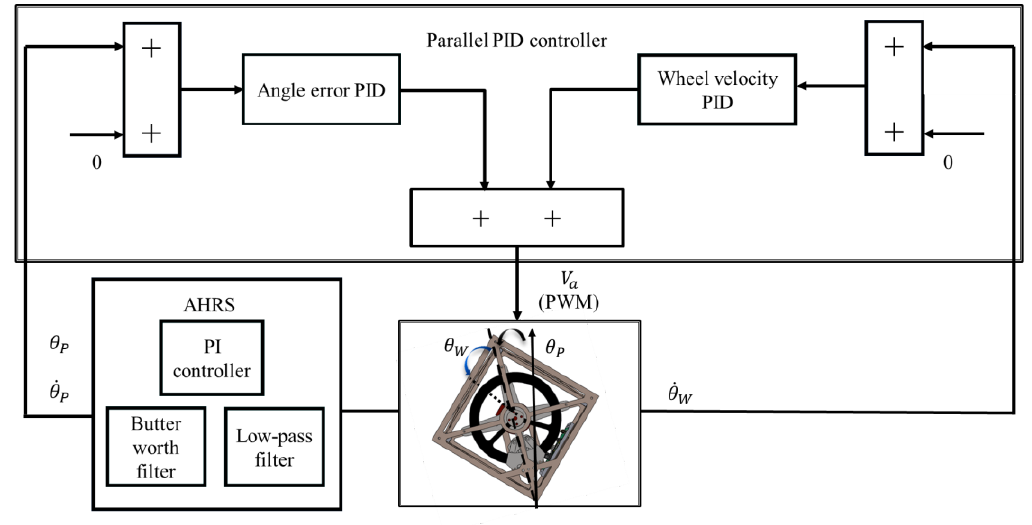
Figure 11. The structure of the cube robot balancing control.